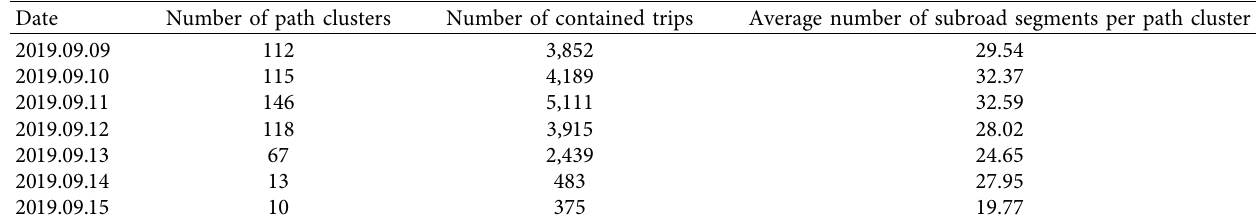
Table 6: Path clustering results from 18:00 to